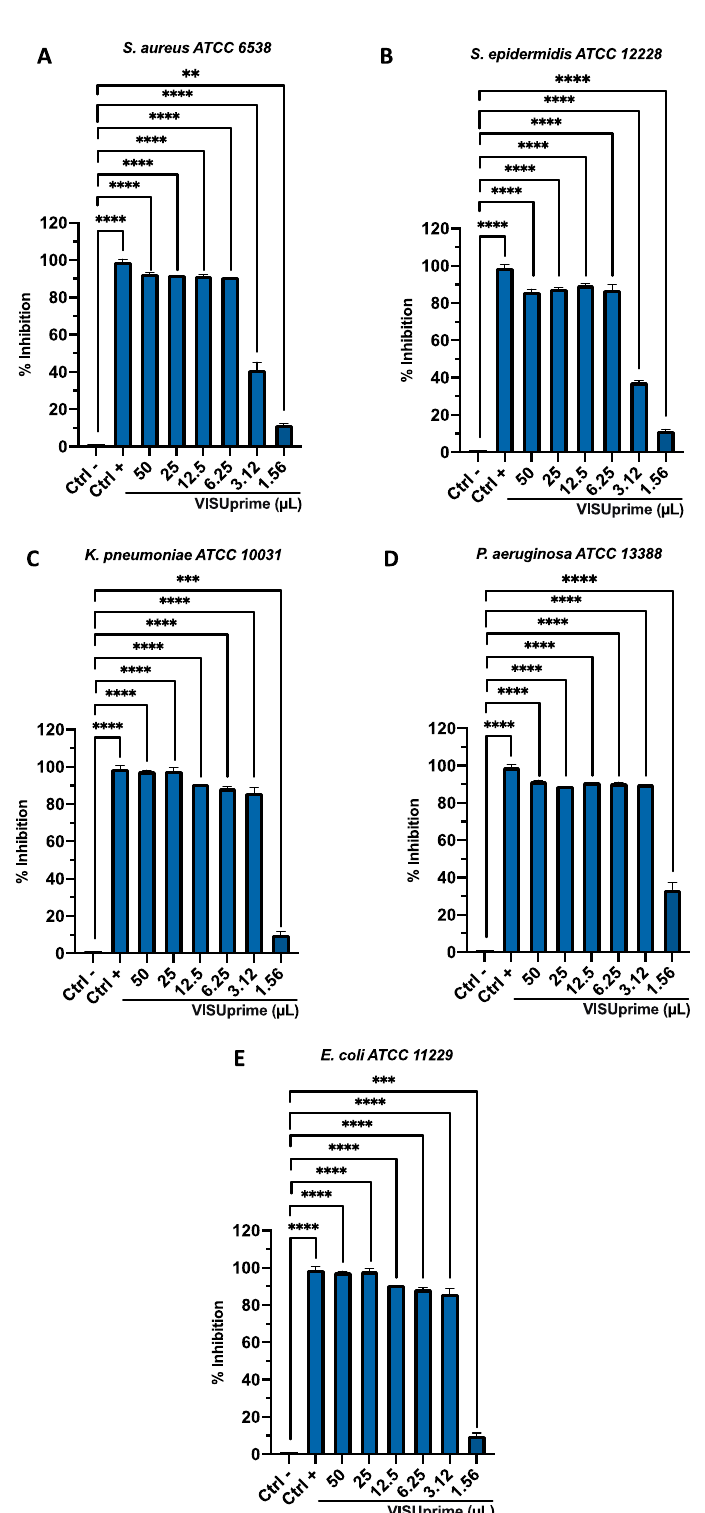
Figure 4. Antimicrobial activity of Visuprime against ( A ) S. aureus (****: p -value < 0.0001, **: p -value = 0.0013); ( B ) S. epidermidis (****: p -value < 0.0001) ; ( C ) K. pneumoniae (****: p -value < 0.0001, ***: p -value = 0.0002); ( D ) P. aeruginosa (****: p -value < 0.0001); ( E ) E. coli (****: p -value < 0.0001, ***: p -value = 0.0006) .